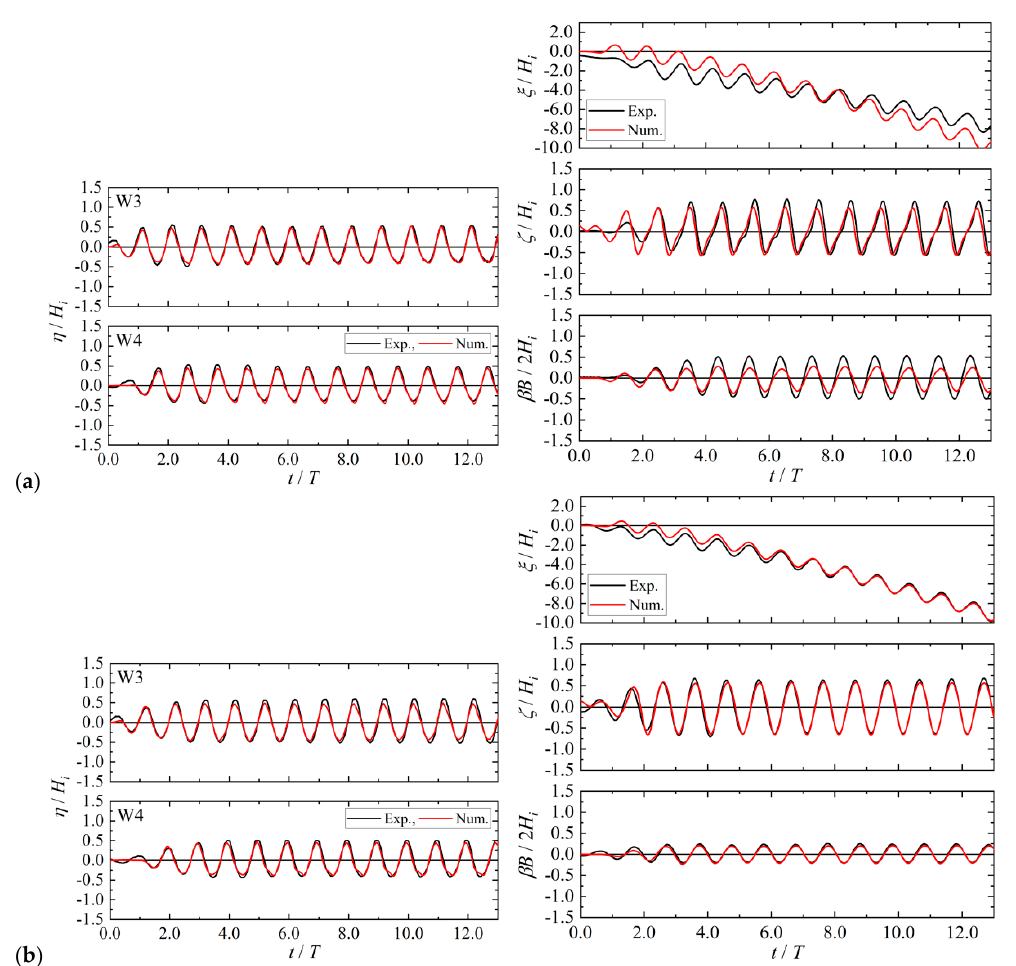
Figure 17. Comparison of the water surface fluctuations η and the surge ξ , heave ζ , and pitch β of the caisson for b f = 30 mm: ( a ) T i = 1.13 s ( f i = 0.88 Hz); ( b ) T i = 3.39 s ( f i = 0.29 Hz).